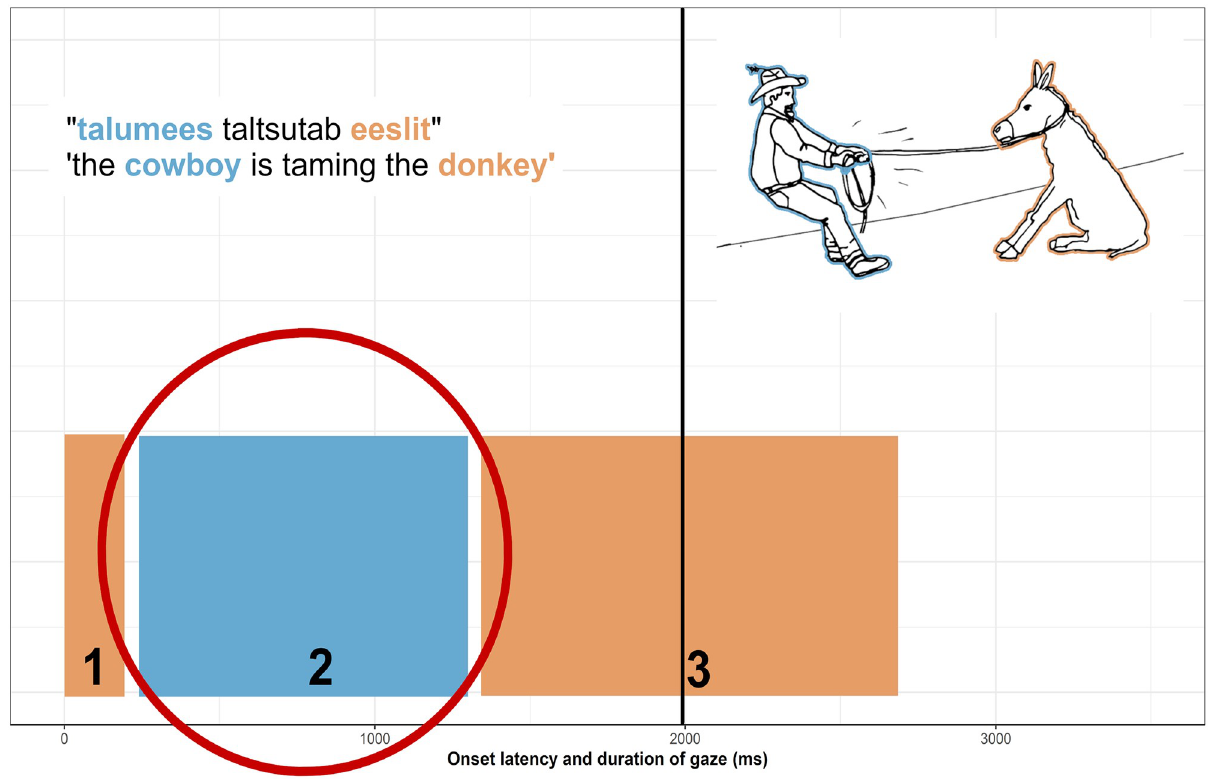
Fig 5. Hypothetical onset latencies (left edge of bars) and duration (widths of bars) of gazes directed to a particular area of interest (e.g., blue refers to the agent initiating and orange to the patient undergoing the action of pulling) during the description of an item ‘man pulling a donkey’ in Estonian. The numbers on the squares count the gazes. The black vertical line indicates the speech onset latency. The red ellipse highlights the gaze that is called ‘naming gaze’ and defined as a gaze of longest duration prior to the start of an utterance. For assessing the degree of incrementality, the duration of the naming gaze is divided by the speech onset latency (for similar analysis procedures and data see, e.g., [19]).